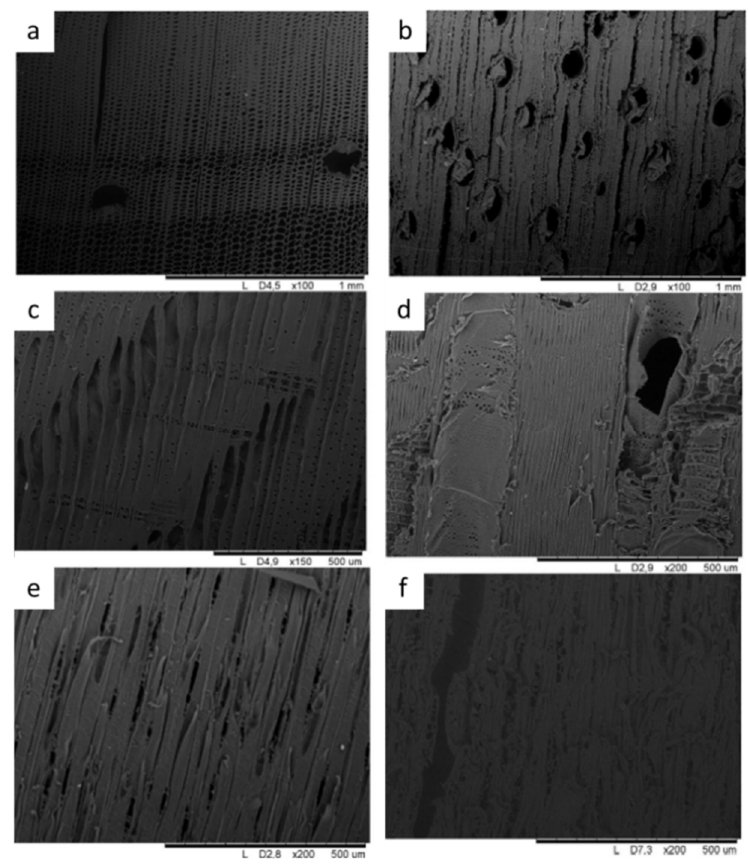
Figure 1. Microscopy of the heat-treated woods. ( a ) P. taeda cross section; ( b ) P. taeda radial section; ( c ) P. taeda tangential section; ( d ) E. grandis cross section; ( e ) E. grandis radial section; ( f ) E. grandis tangential